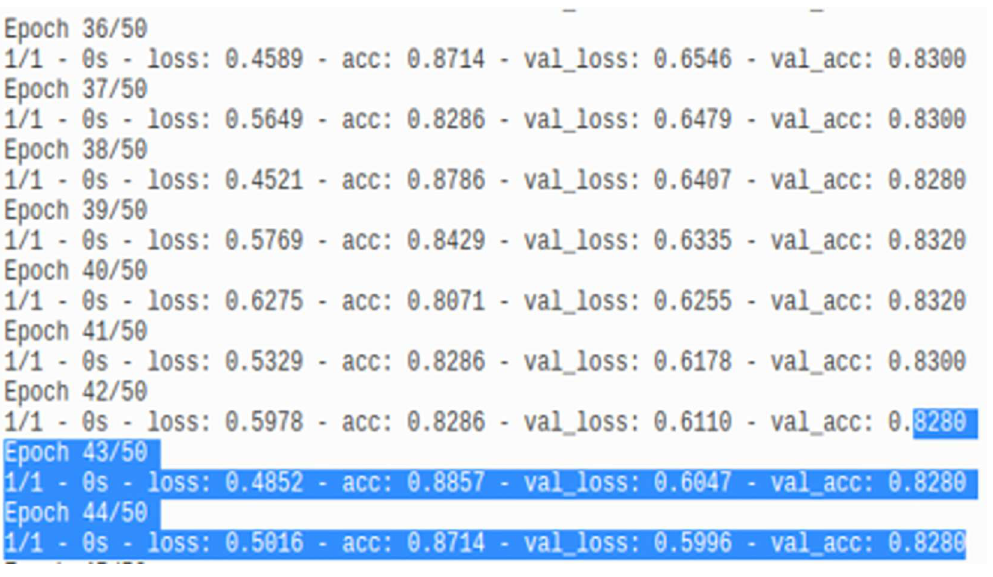
Fig 26. Model loss and accuracy history.